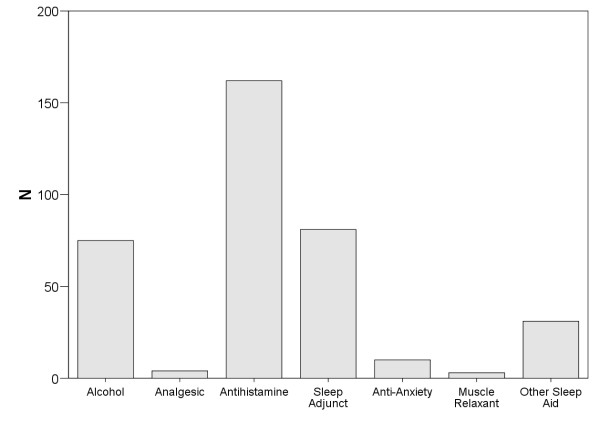
Sleep aids used by the 458 respondents who provided detailed information.